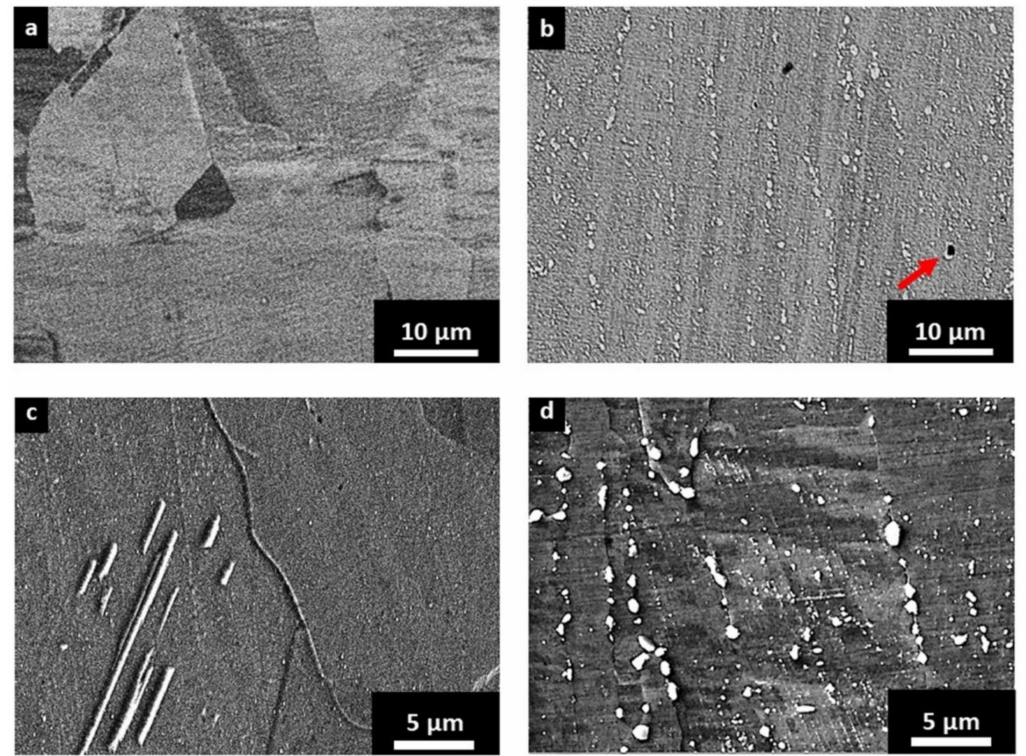
Figure 7. SEM images of the ( a , c ) SOL IN625 and ( b , d ) SOL IN625/TiC samples revealing the morphology and dimensions of the carbides. The red arrow indicates a TiC particle acting as a site for the formation of MC